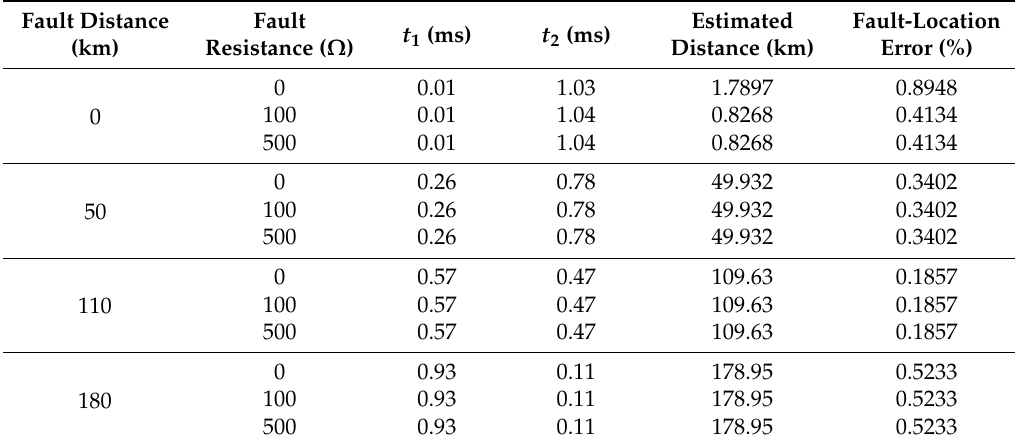
Table 1. Fault-location results for various PG faults.